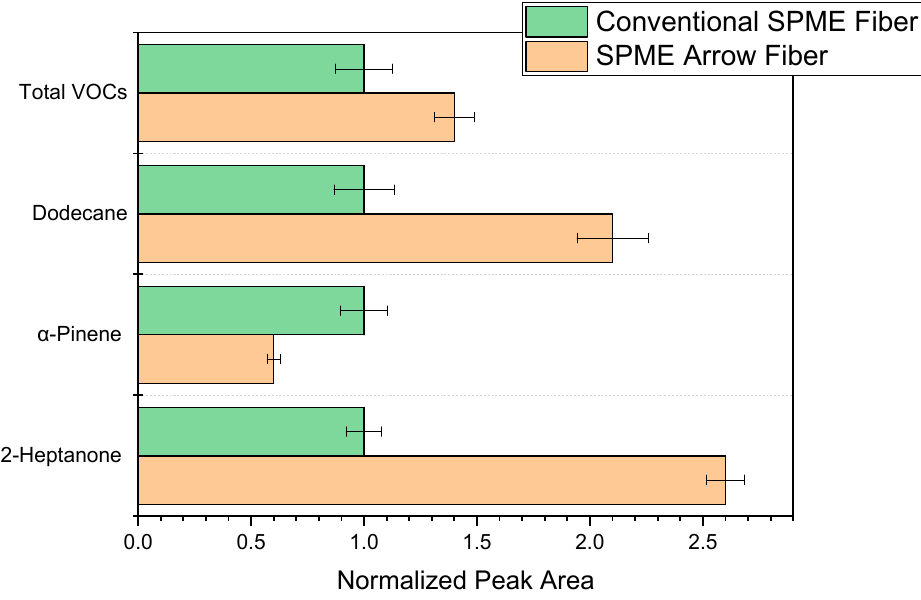
Figure 6. Sensitivity comparison for Carbon wide range (WR) SPME Arrow/polydimethylsiloxane (CAR/PDMS) SPME Arrow fiber and conventional CAR/PDMS SPME fiber.